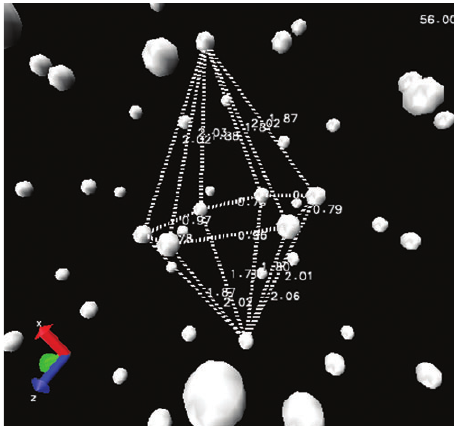
Figure 2 Hexagonal dipyramid formation in the ground state of C60@H58.